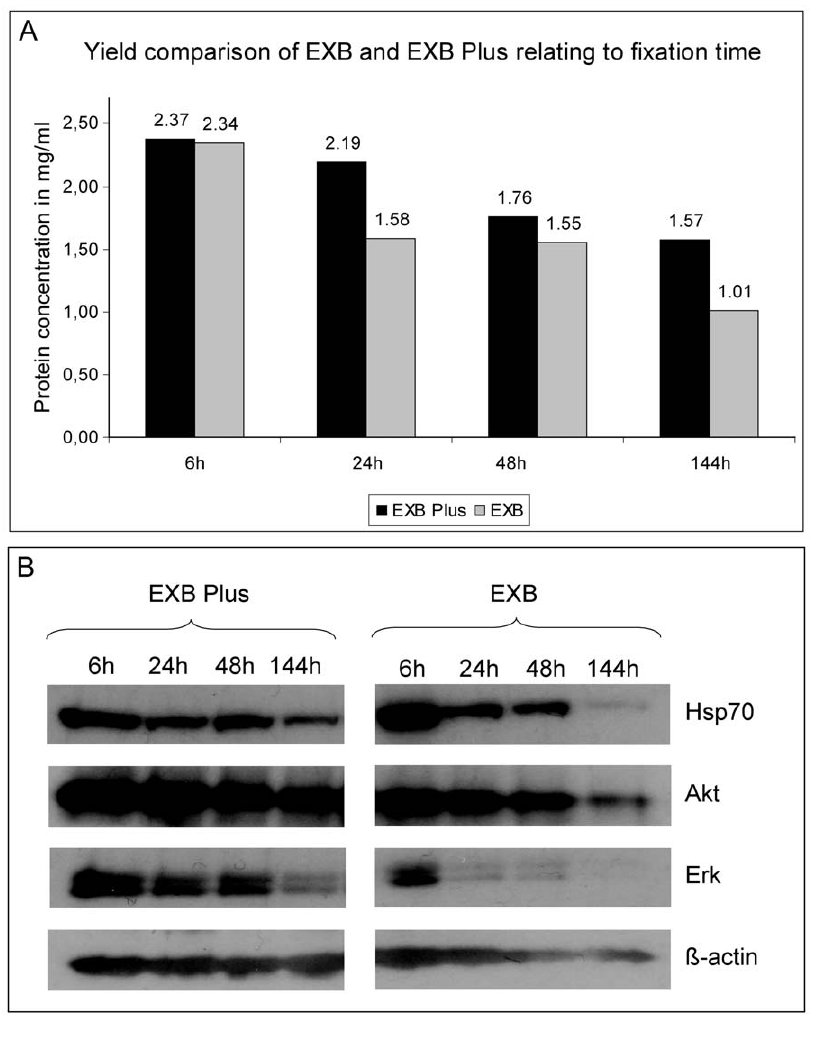
Figure 5. Protein amounts and western blot analysis of lysates extracted from lymph node samples fixed for 6 h, 24 h, 48 h and 144 h, respectively. For a short fixation time no real difference could be detected between the two buffers tested. But already at the standard fixation time of 24 h EXB Plus shows 25% higher protein yield. For a fixation time of 144 h the difference increased to 30% higher protein yield compared to EXB. B Western blot analysis of Hsp70, Akt, Erk and b -actin in lymph node samples fixed for 6 h, 24 h, 48 h or 144 h. Protein yield decreases with extension of fixation for EXB, for all four analysed proteins. In contrast, using EXB Plus the decline is much less pronounced. All eight samples detected with one antibody were run on one gel and detected under exactly the same conditions (e.g. blocking, washing steps, exposure time).